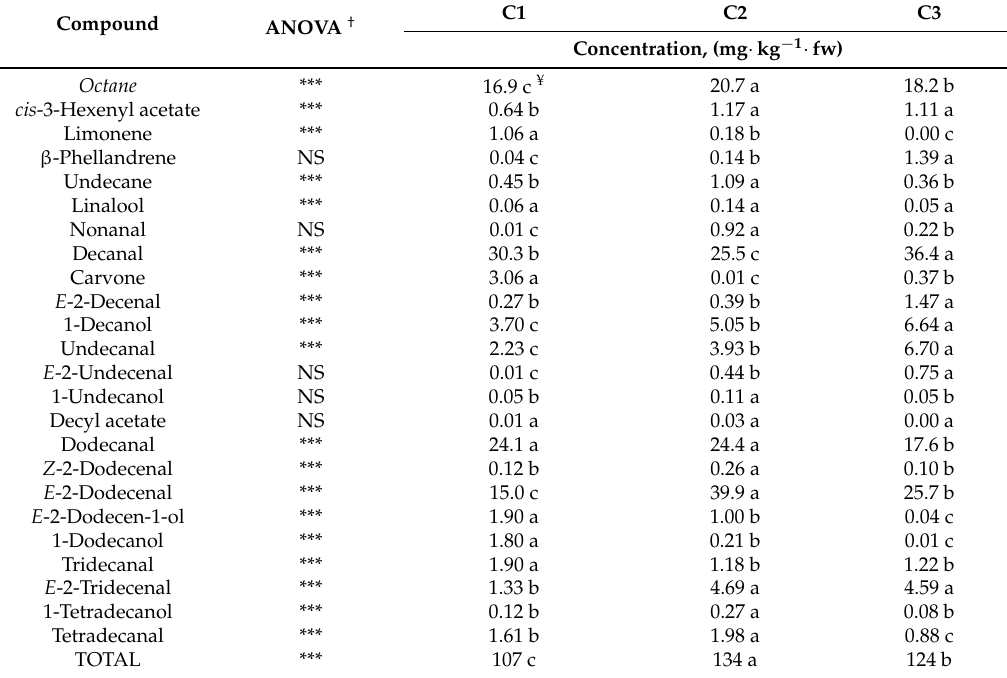
Table 4. Volatile composition of coriander essential oil at three commercial stages (mg ¨ kg ´ 1 ¨